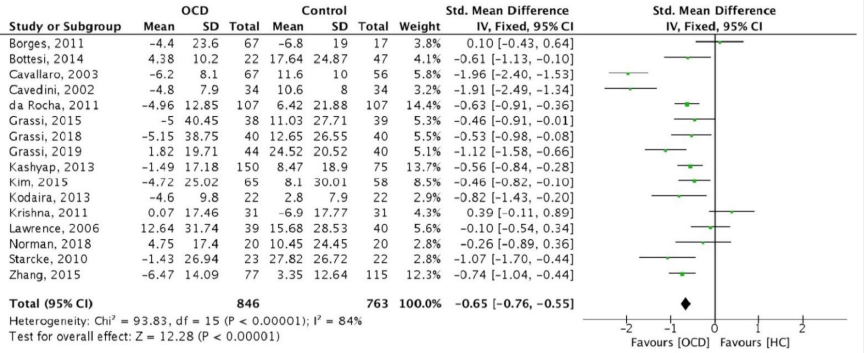
Figure 2. Forest plot of the 16 studies included in the meta-analysis.